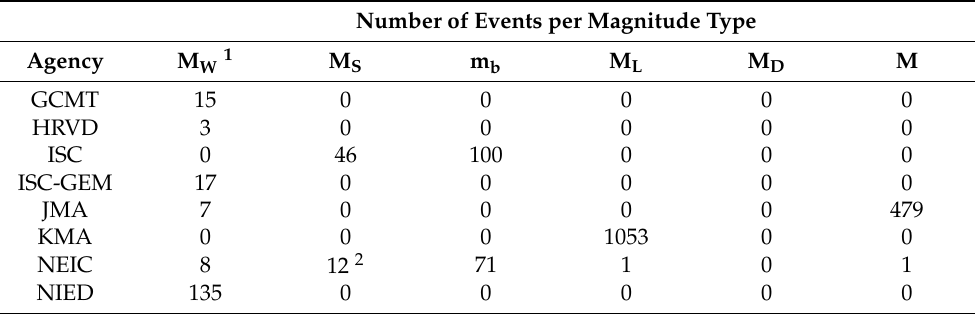
Table 7. Number of earthquakes by seismological agency and magnitude type for South Korea. Number of Events per Magnitude Type